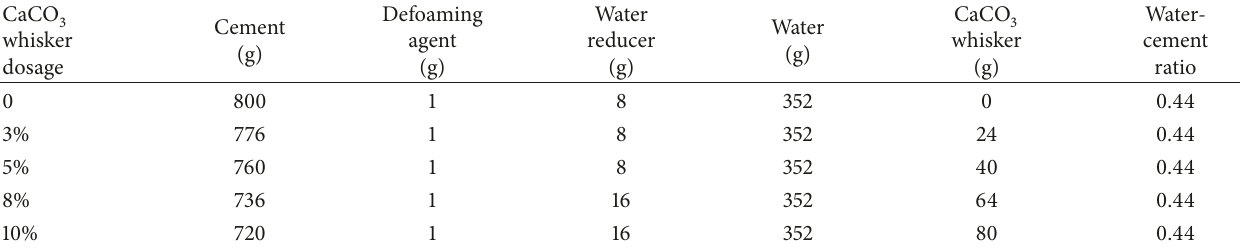
Table 2: Mix proportions of cement